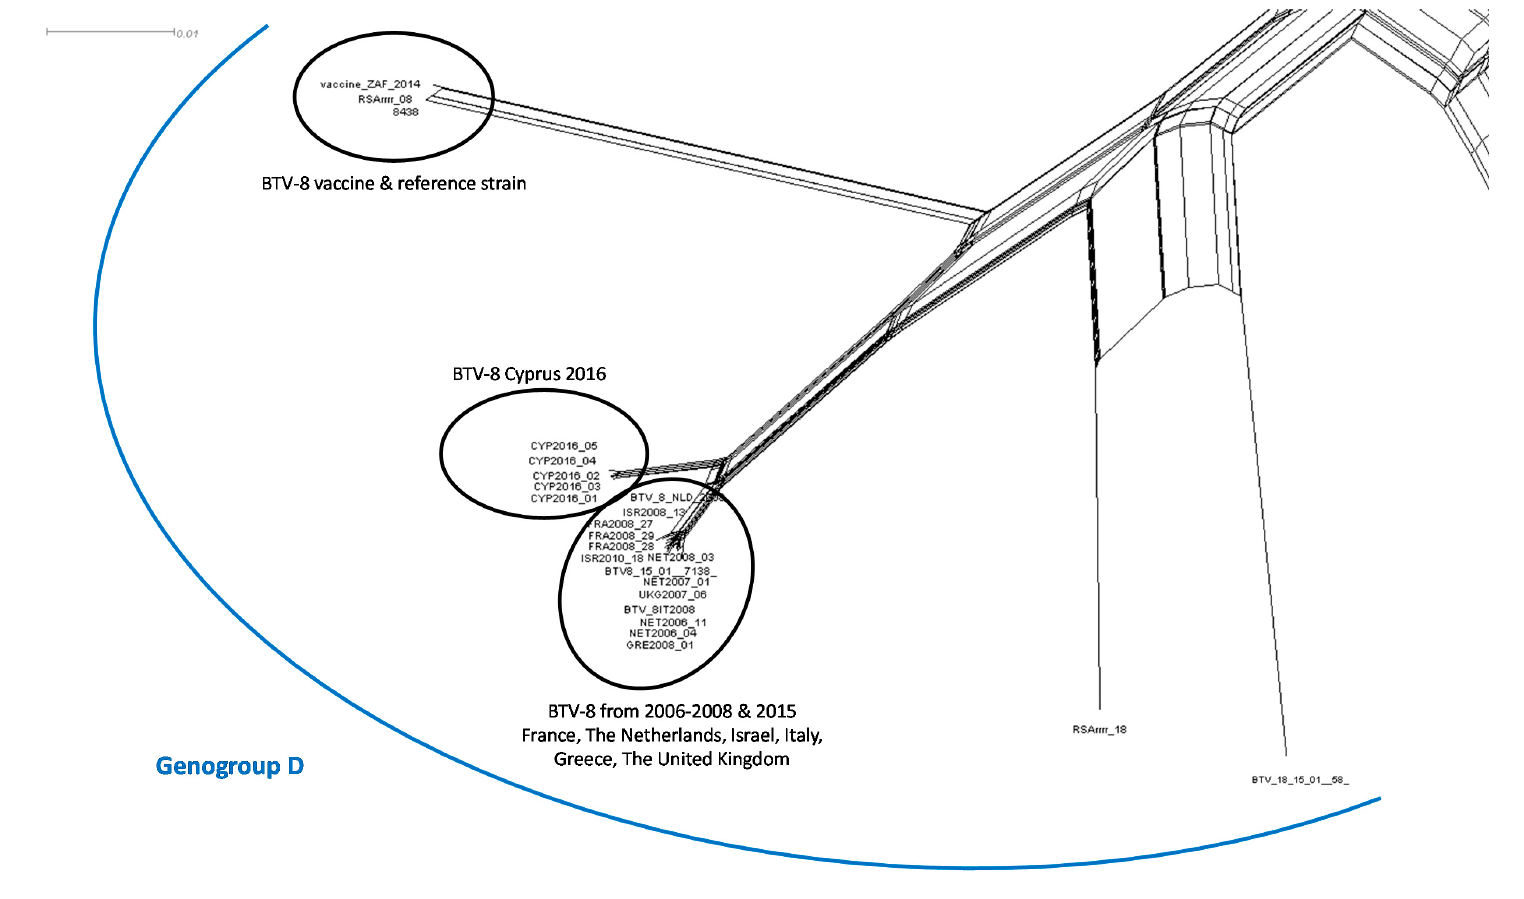
Figure 2. ( a ) The Neighbor-Net network was estimated from an alignment of 18,621 characters for each of 73 taxa, which sequence composed of the concatenated coding regions of BTV (VP1–VP7 and NS1–NS3); and ( b ) genogroup D of the Neighbor-Net network. Nomenclature used in-line with that proposed by the BTV-GLUE resource for the BTV Segment 2. Solid coloured lines were added manually to indicate the genogroup while the dashed blue lines were added manually to indicate the distinct differences between the western and eastern topotypes, and genogroup K which contains the atypical BTV strains.